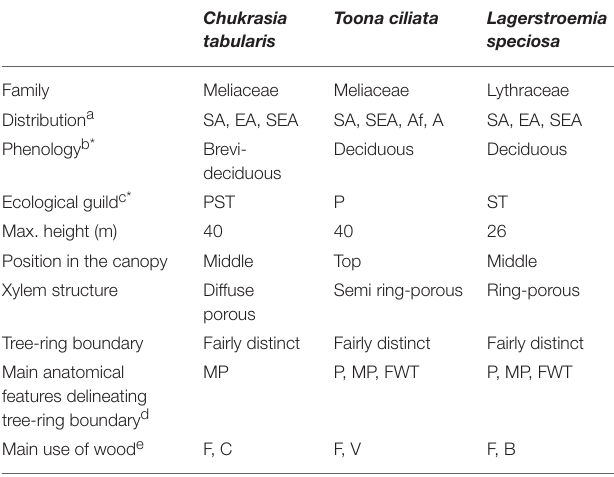
TABLE 1 | Characteristics of studied species. Chukrasia Toona ciliata Lagerstroemia tabularis speciosa Family Meliaceae